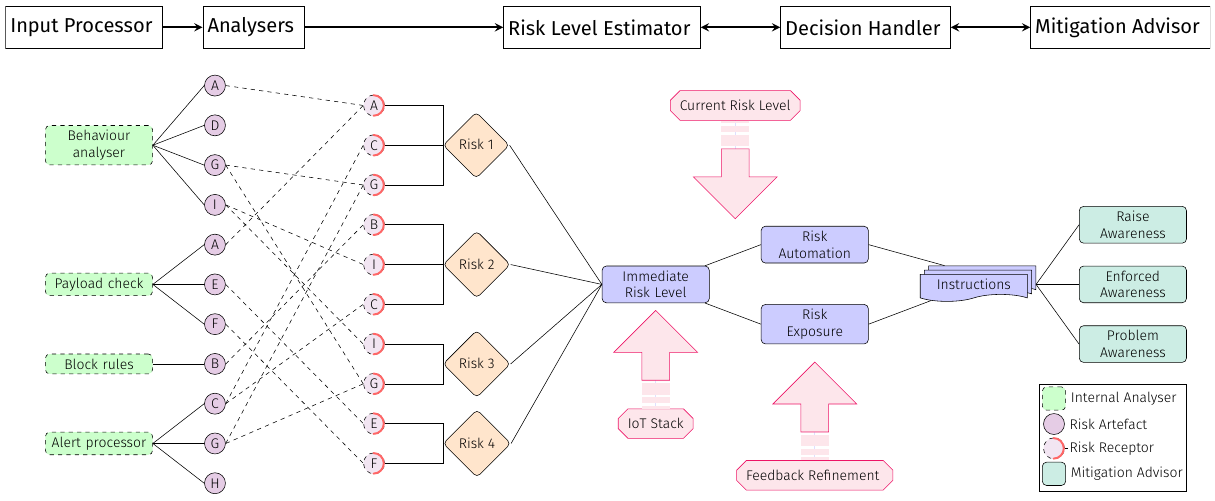
Figure 5. DRAF architecture with data flow and risk